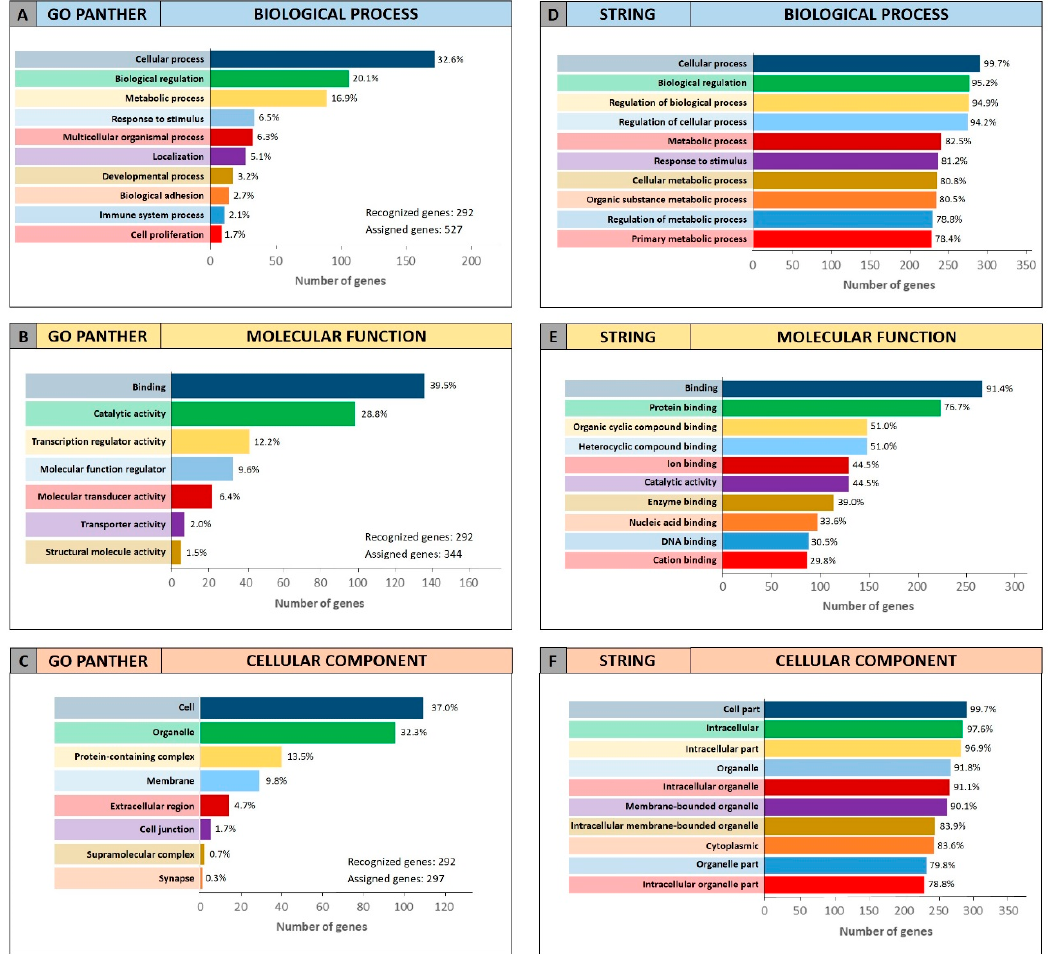
Figure 9. Gene Ontology enrichment of the 345 genes identified through DIANA-mirPath. Panel ( A , D ) GO PANTHER and STRING analyses of the “biological process” category; panel ( B , E ) GO PANTHER and STRING analyses of the “molecular function” category; panel ( C , F ) GO PANTHER and STRING analyses of the “cellular component” category.